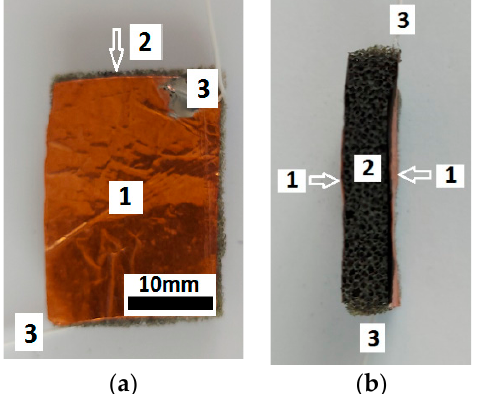
Figure 9. ( a ) Front view photo of the MTS; ( b ) lateral view photo of the MTS (1, copper foil; 2, MTS; 3, electrical connection).